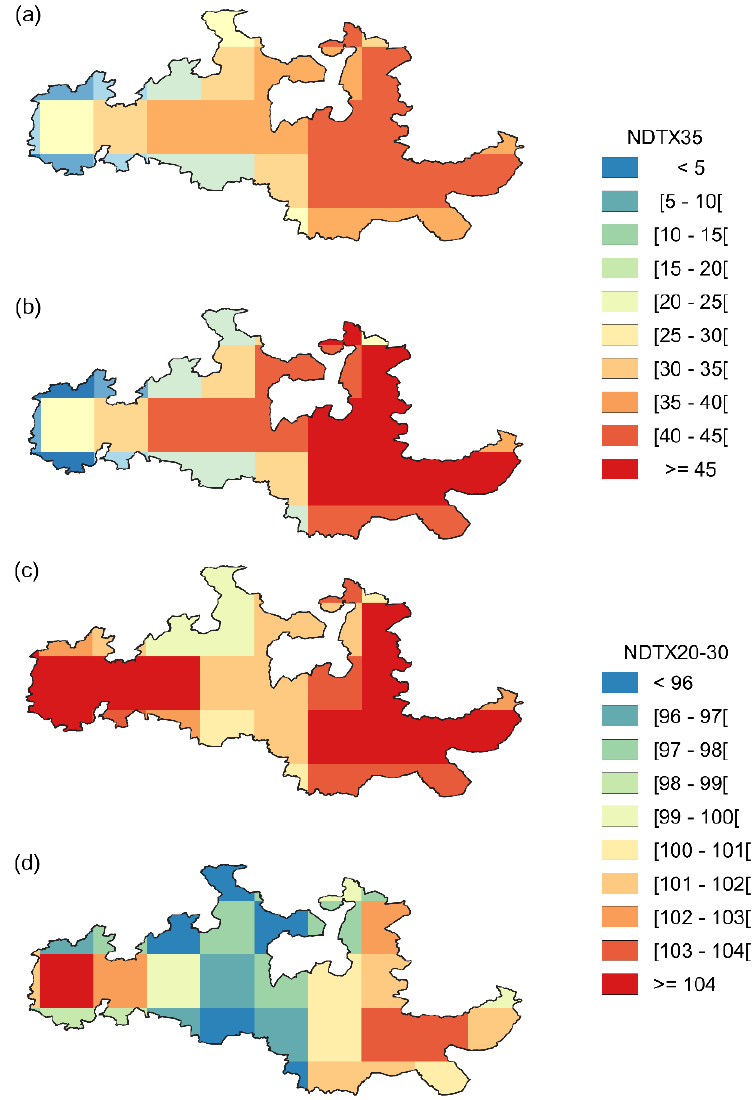
Figure 4. Ensemble-mean of the Number of Days with maximum temperatures above 35 ◦ C